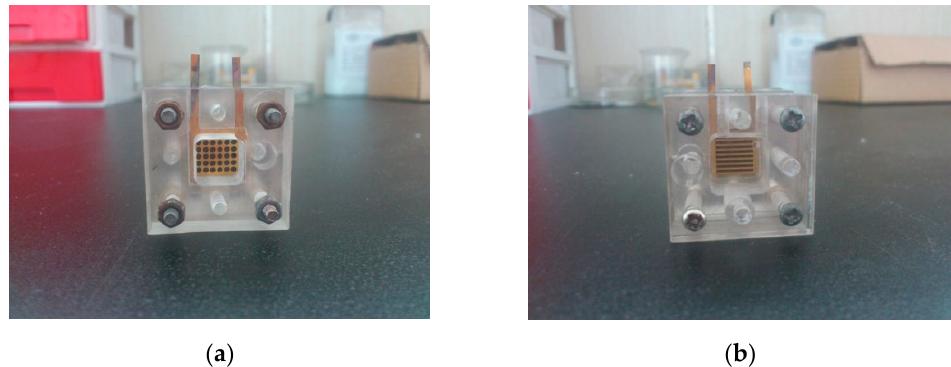
Figure 5. Photograph of the assembled μ -DMFC: ( a ) photograph of the MEA with trilaminar-catalytic layer; ( b ) partial PF cathode scanning electron microscope image (SEM).